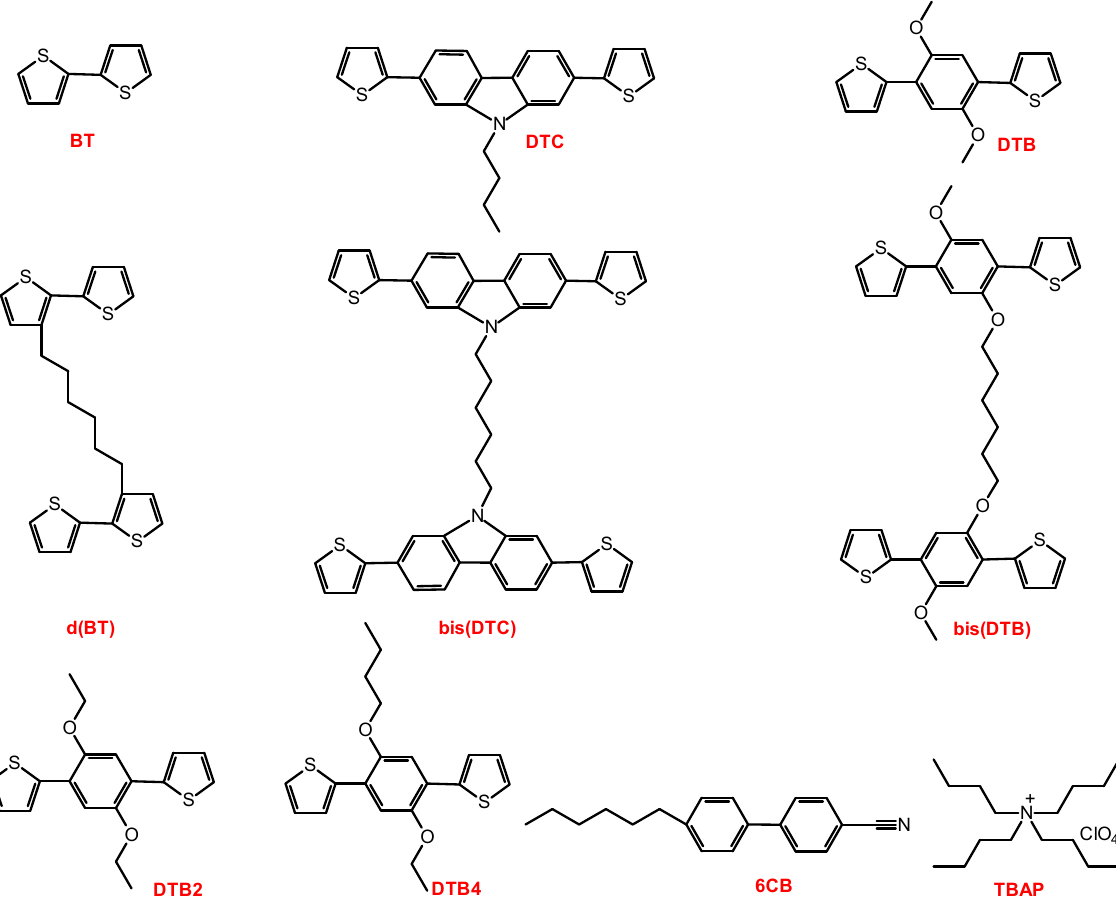
Scheme 1. Monomers employed for the electrochemical polymerization in liquid crystals, and molecular structures of liquid crystal 4-cyano-4′-hexylbiphenyl (6CB) and the supporting salt tetrabutylammonium perchlorate (TBAP).